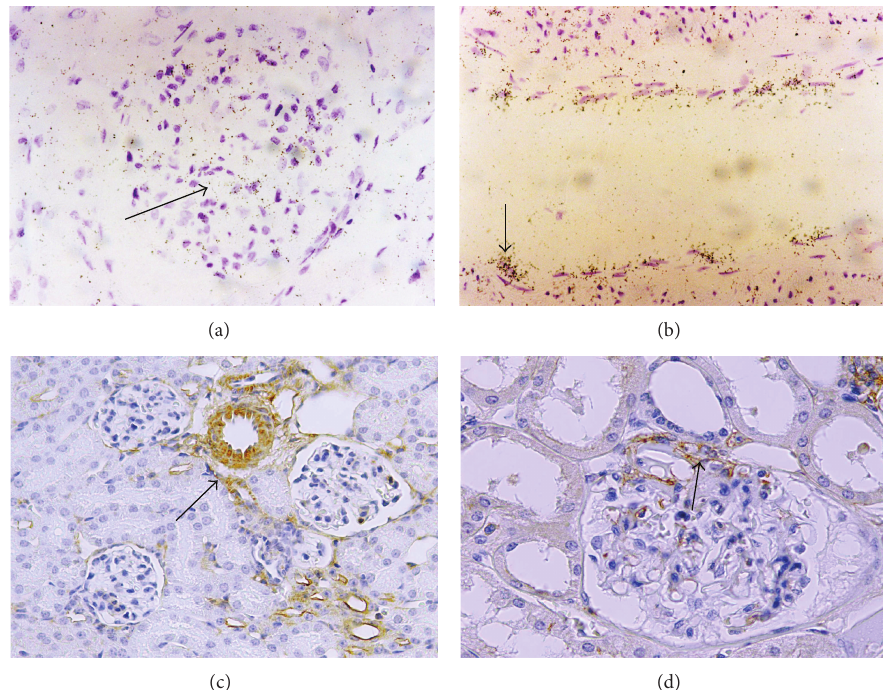
Figure 2: PGIS mRNA localizes to mesangial fields ((a), arrow) and endothelial cells of an interlobar artery ((b), arrow). Expression of PGIS protein and mRNA in normal adult kidney. (c) Low power view shows expression of PGIS in endothelial and smooth muscle cells of an arcuate artery (arrow). (d) shows expression of PGIS in cells of the juxtaglomerular apparatus (arrow), adjacent to the macula